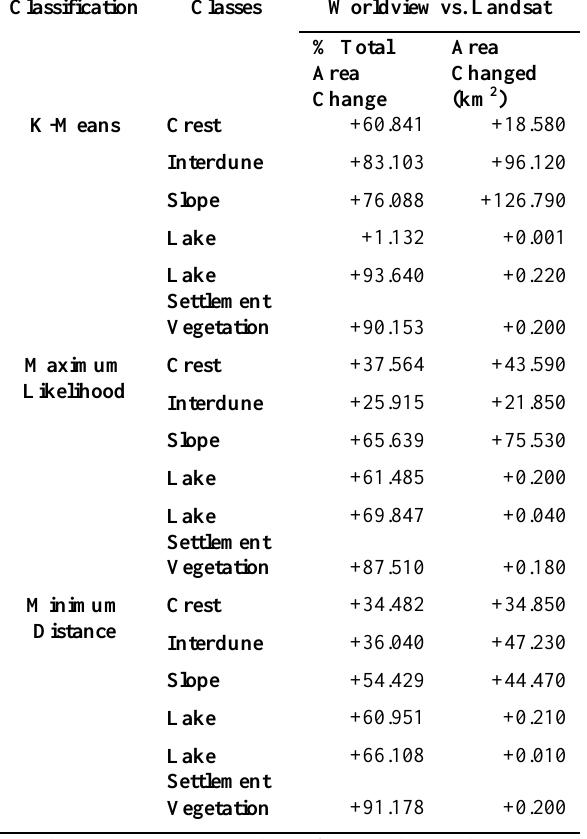
Table 9: Change in the total area for the selected classes in both percentage and km 2 from Worldview to Landsat for the different classifications modules.